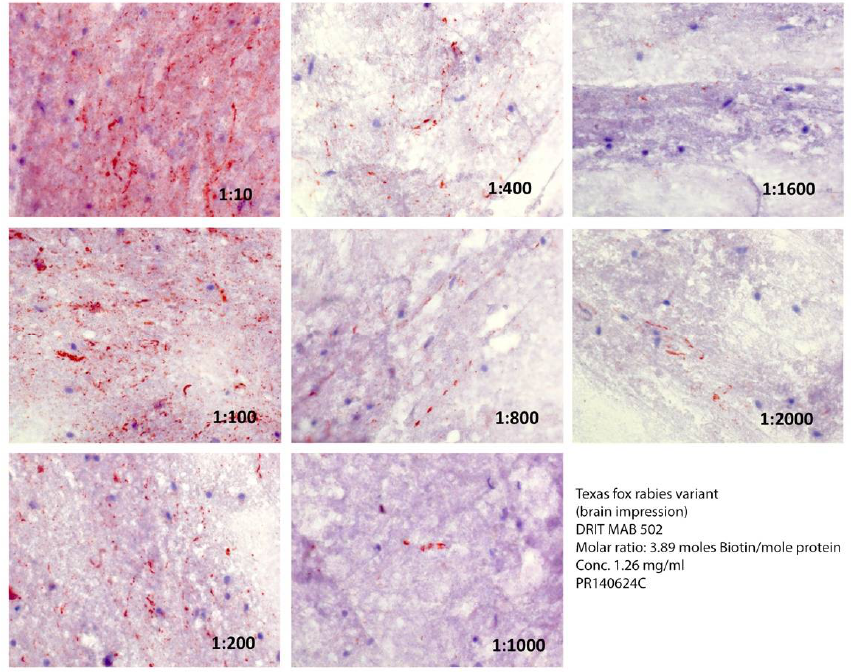
Figure 3. Comparative reactivity of serial dilutions of the DRIT MAB 502 at a ratio of 3.9 moles of biotin per mole of protein against a gray fox rabies virus variant. Based upon the biotin and viral variant comparison, 3.9 moles of biotin were chosen for MAB 502 and 802 conjugations. From the 816 animal brain samples examined, the sensitivity and